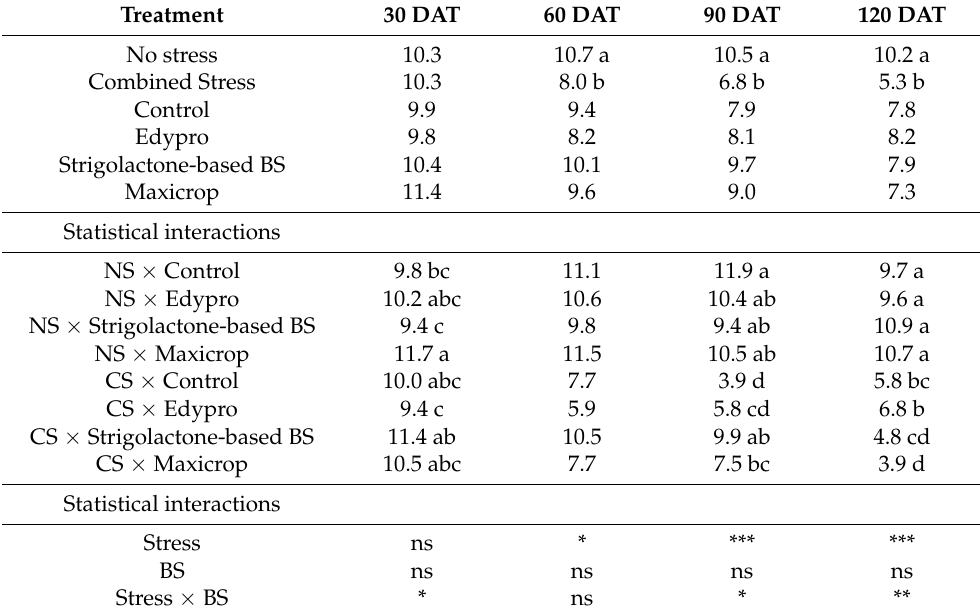
Means ( n = 4) followed by different letters indicate significant differences according to Duncan’s multiple range test ( p < 0.05), at p < 0.05, p < 0.01, and p < 0.001, denoted by *, **, and ***, respectively; ns = not significant.